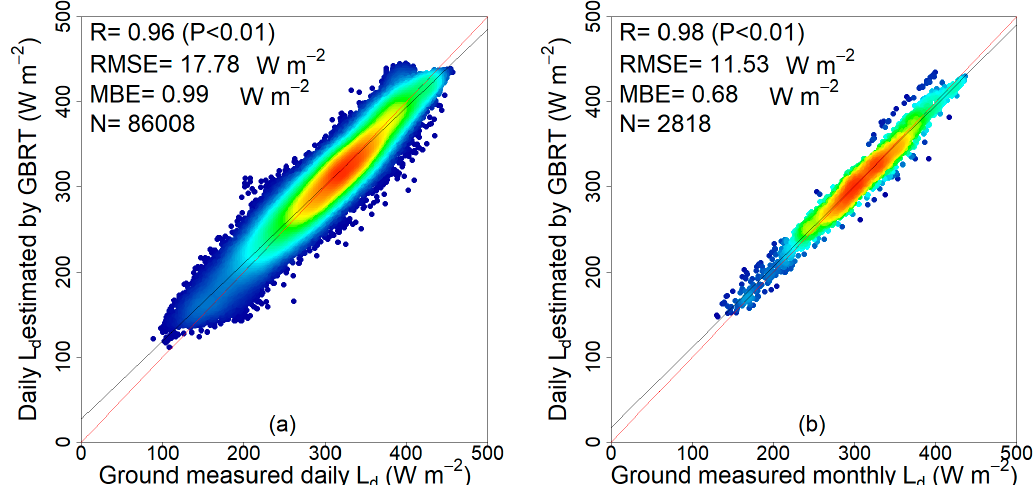
Figure 4. Evaluation results of L d estimates with 5-km resolution based on the GBRT model on the ( a ) daily and ( b ) monthly time scales against the ground measurements from March 2000 to December 2018.